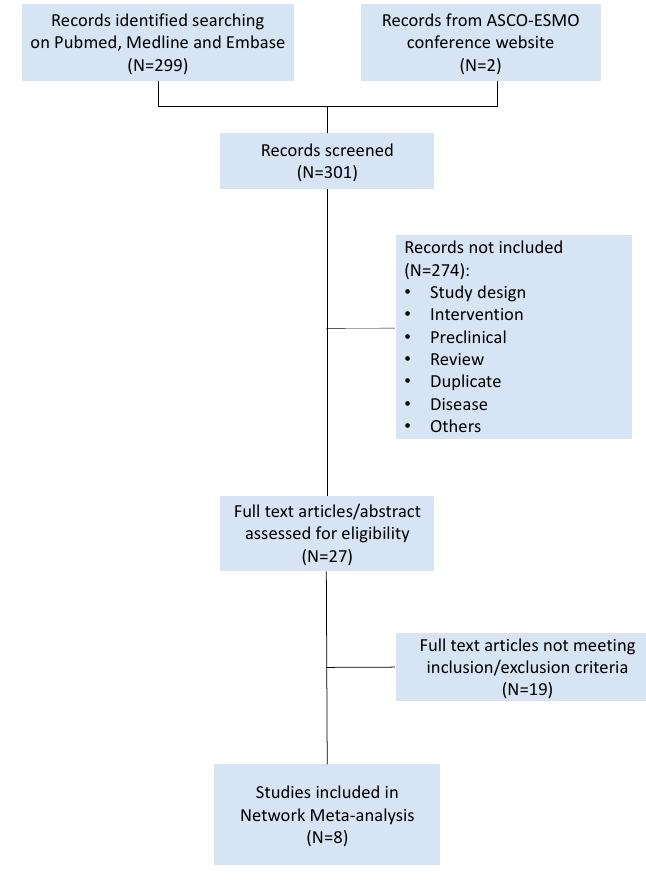
Figure 4. PRISMA flowchart of platinum-sensitive recurrent ovarian cancer randomized controlled trials.